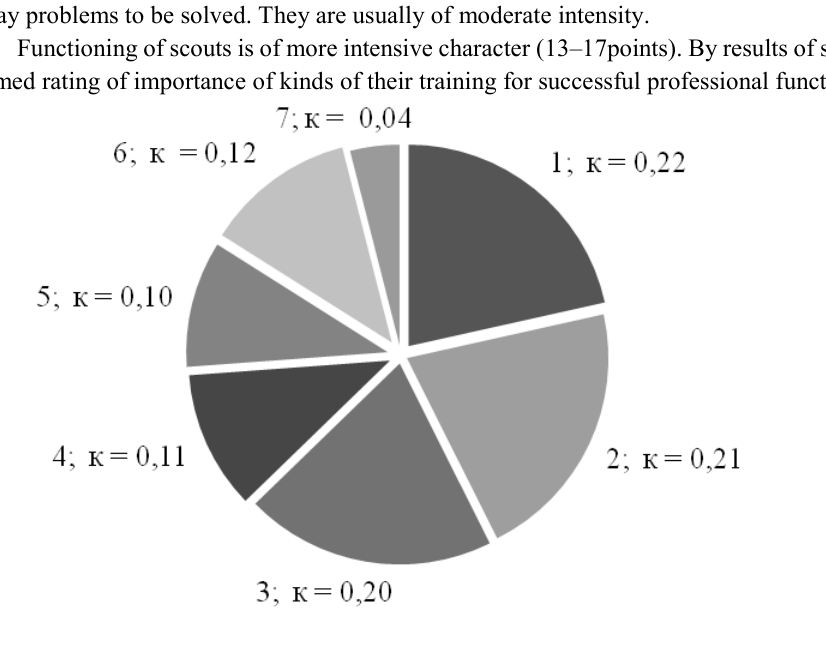
Fig.1. Rating of importance of kinds of scouts’ training (by weight coefficient value, к ),